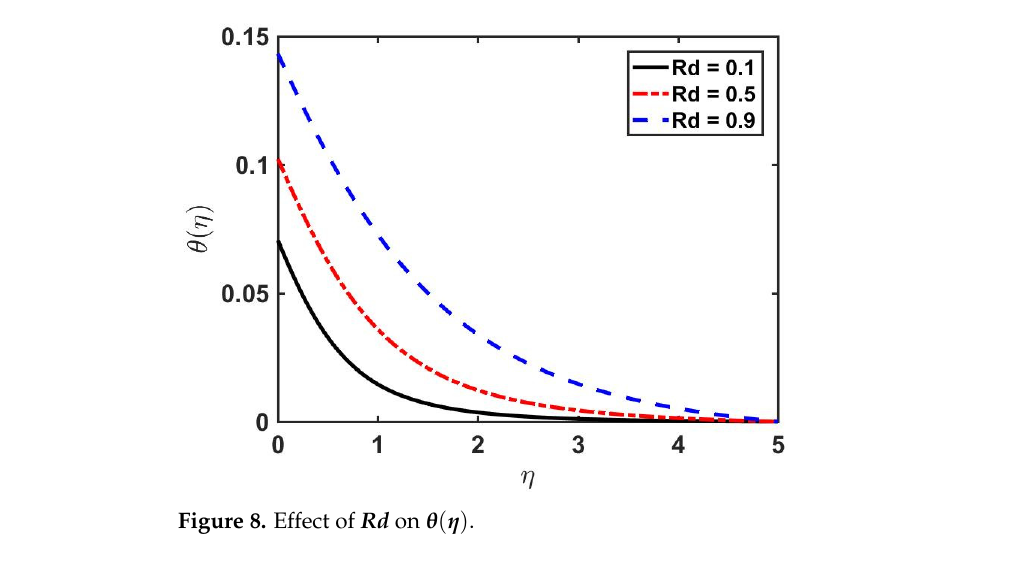
Figure 7. Effect of 𝜽 𝒘 on 𝜽(𝜼) .